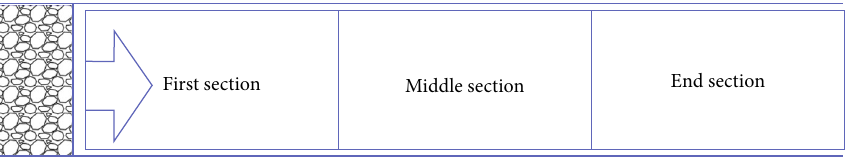
Figure 4: The sections divided in the roadway for